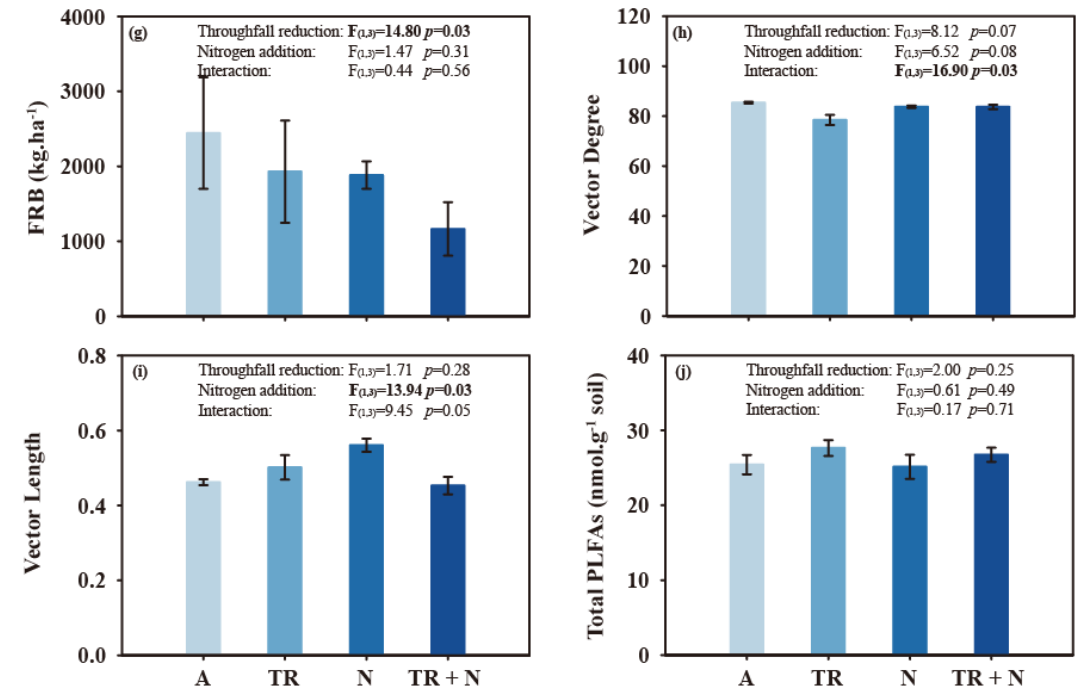
Figure 2. Soil properties, fine roots biomass, and vector analysis of soil enzymatic stoichiometry in soils under ambient (A), throughfall reduction (TR), N addition (N), and throughfall reduction and N addition (TR + N) treatments. TOC: soil total carbon (Graph ( a )); TN: soil total nitrogen (Graph ( b )); TP: soil total phosphorus (Graph ( c )); pH: soil pH values (Graph ( d )); NO 3 -N: nitrate nitrogen (Graph ( e )); NH 4 -N: ammonium nitrogen (Graph ( f )); FRB: fine root biomass (Graph ( g )); Vector Degree (Graph ( h )); Vector Length (Graph ( i )); Total PLFAs: soil phospholipid fatty acid (Graph ( j )). The error bar represented arithmetic means ± stand errors for four replicates.